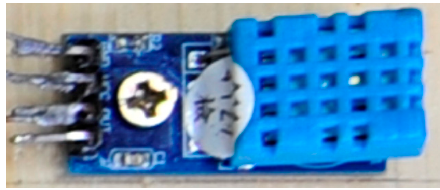
Figure 4. DHT11temperature sensor.